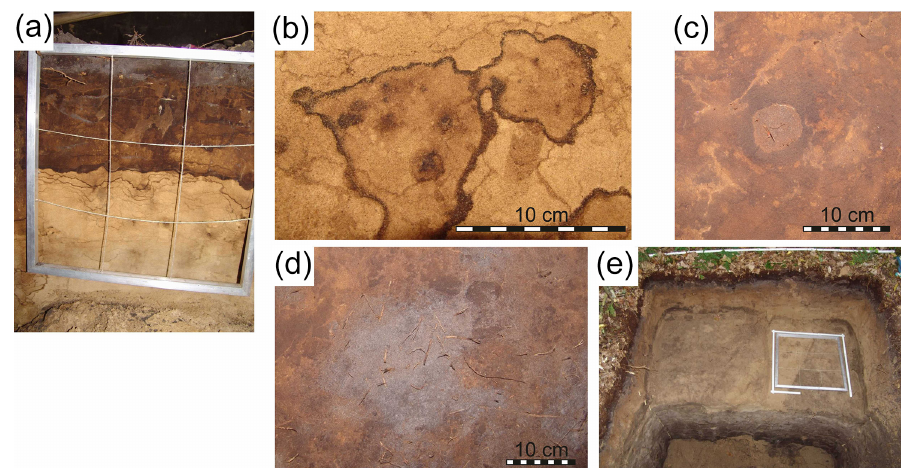
Figure 2. Detailed pictures of the profile, with (a) showing the profile wall and (b–e) displaying view on horizontal levels. Note that the inner length of the square-shaped aluminum frame is 0.5m. (a) Depth interval 1.5–2m with clearly visible boundary between the relict Entic Podzol (rEP) and cover sand (cs). (b) Decomposed roots surrounded by dark accumulations of humic material and iron and manganese oxides at 1.8m depth. (c, d) Pick marks in the rEP (reddish-brown) filled with gray plaggic material at 1.65 and 1.5m depth, respectively. (e) Top of the Plaggic Anthrosol (PA) with visible plow furrow crossing the horizontal level diagonally, filled with yellow drift sand (ds). The left half of the horizontal layer is located at 0.4m depth, the right half at 0.5m depth.